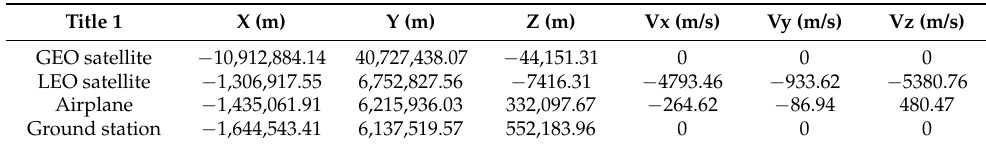
Table 1. The initial locations of the observers in